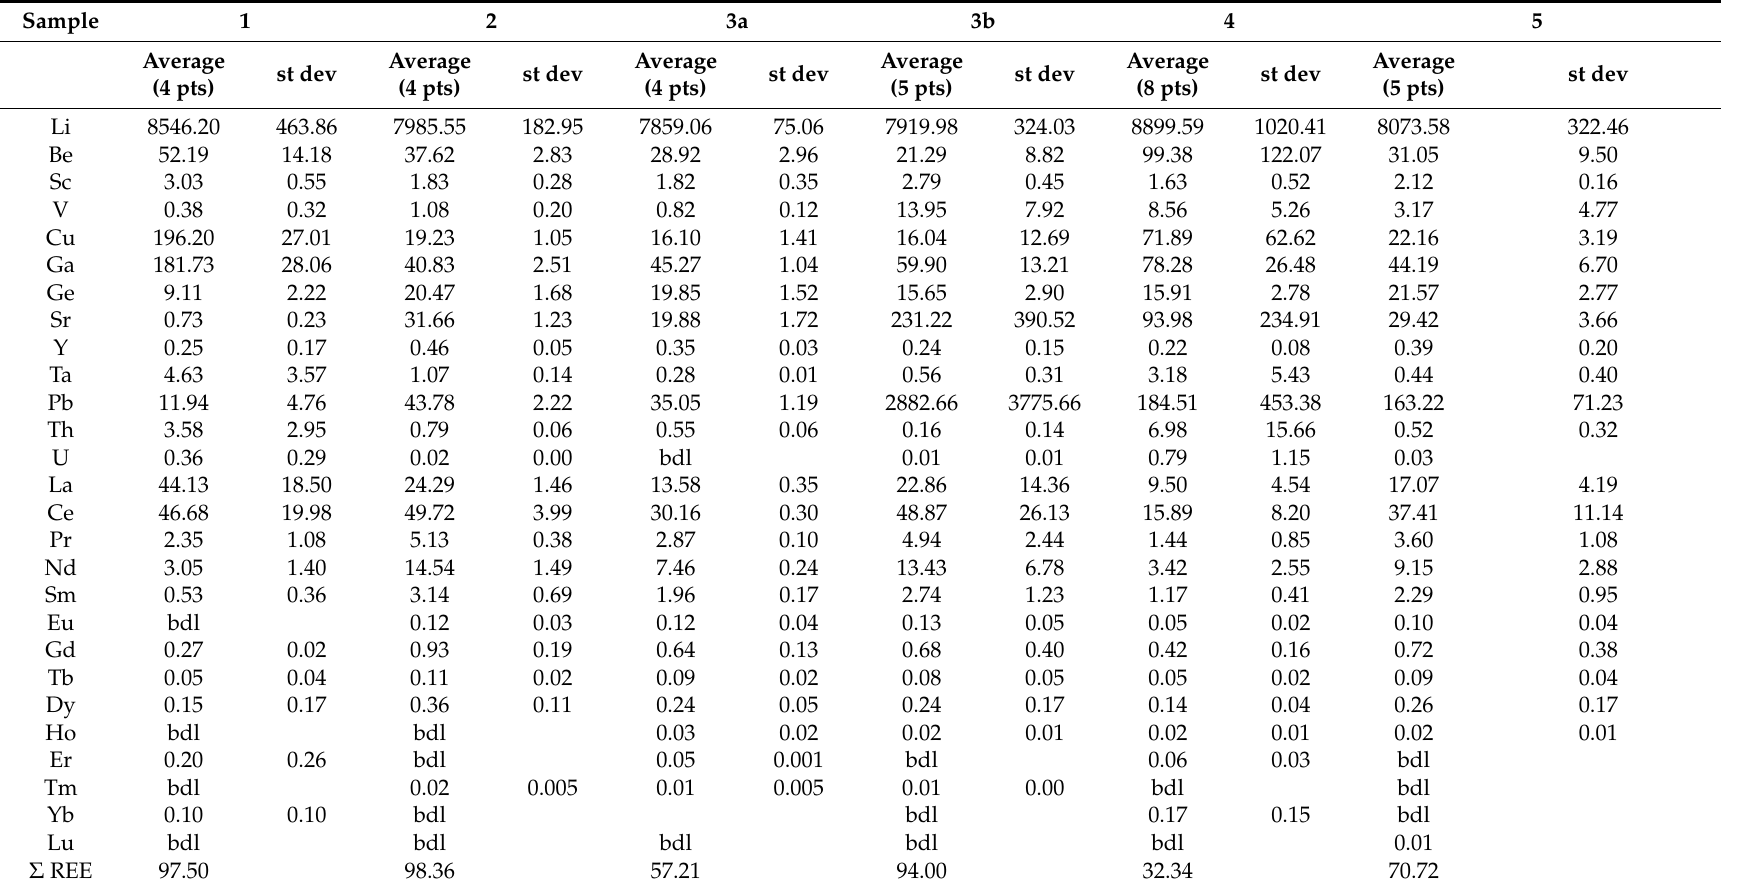
Table 3. LA–ICP–MS analyses of trace elements in studied tourmalines